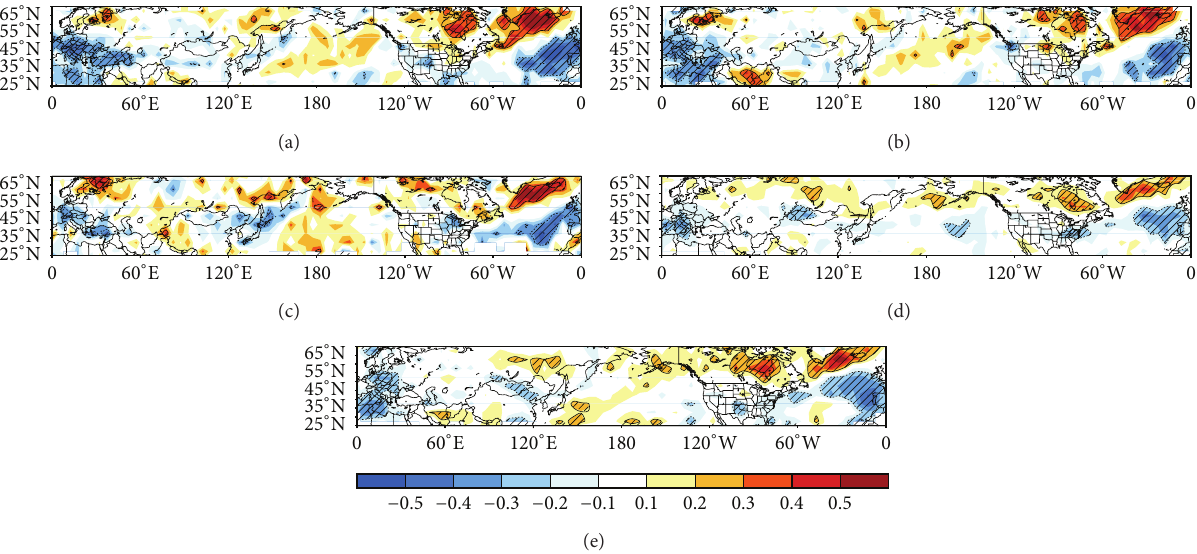
Figure 8: Partial correlation coefficient for storm frequency versus NAO for NH in JFM (excluding IOD and El Ni˜no). Correlation (shaded), 95% significance (hatched) for (a) NCEP1, (b) ERA40, (c) CFSR, (d) CMIP1, and (e) CMIP2.